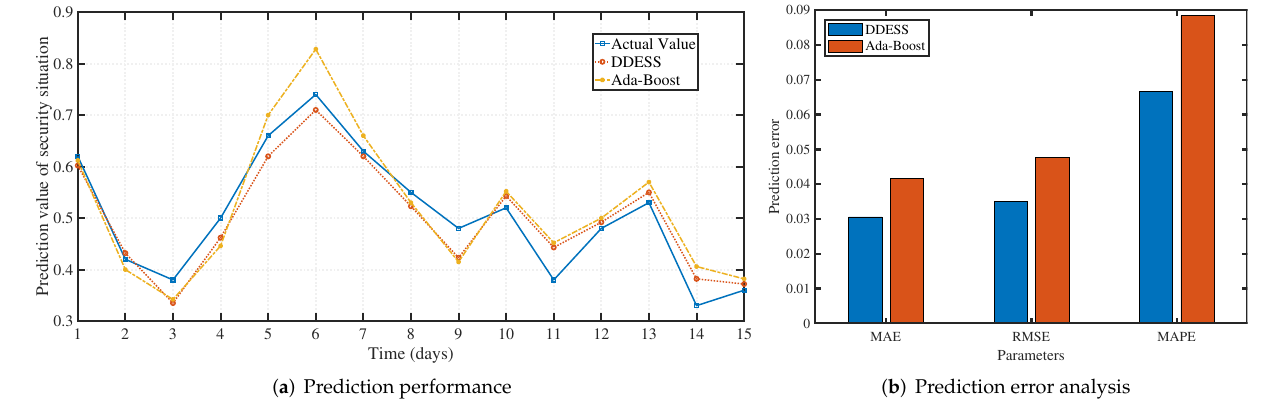
Figure 9. Prediction performance comparison on situation